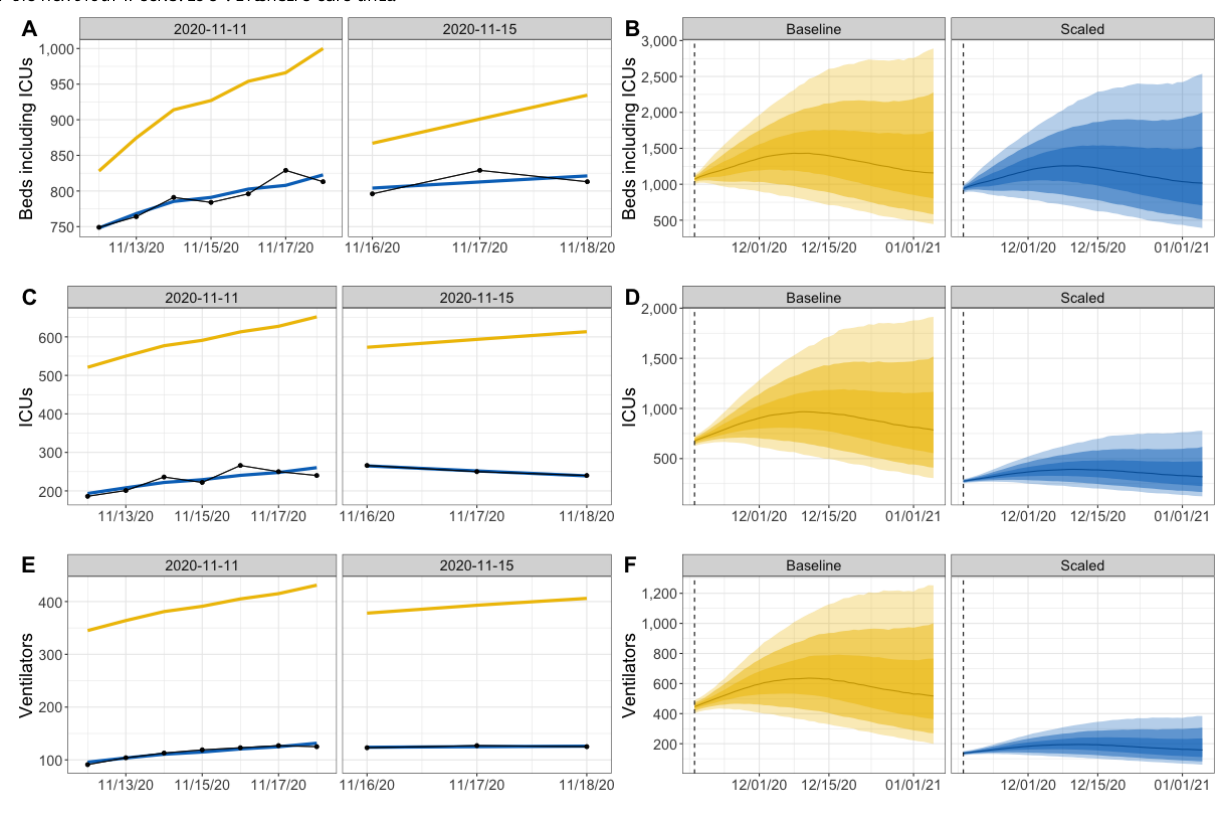
Figure 2. Back-fitting procedure for the November 18, 2020, forecast for New Mexico. (A, C, E) For each forecast from over the week (the panels), a regression was fit (blue line) from the 50th percentile of the baseline forecasts (yellow line) to the observed data (black dots). A time-weighted average of the 2 regression coefficients from each panel was calculated separately for inpatient beds (A), ICU beds (C), and ventilators (E). (B, D, F) For the November 18 forecast, the Baseline forecast was multiplied by the time-weighted average of the regression coefficients to produce the Scaled forecast for the next four weeks. ICU: intensive care